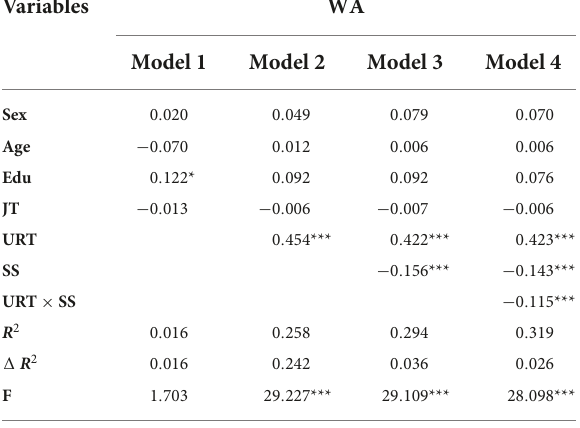
TABLE 6 Results of the test for moderating